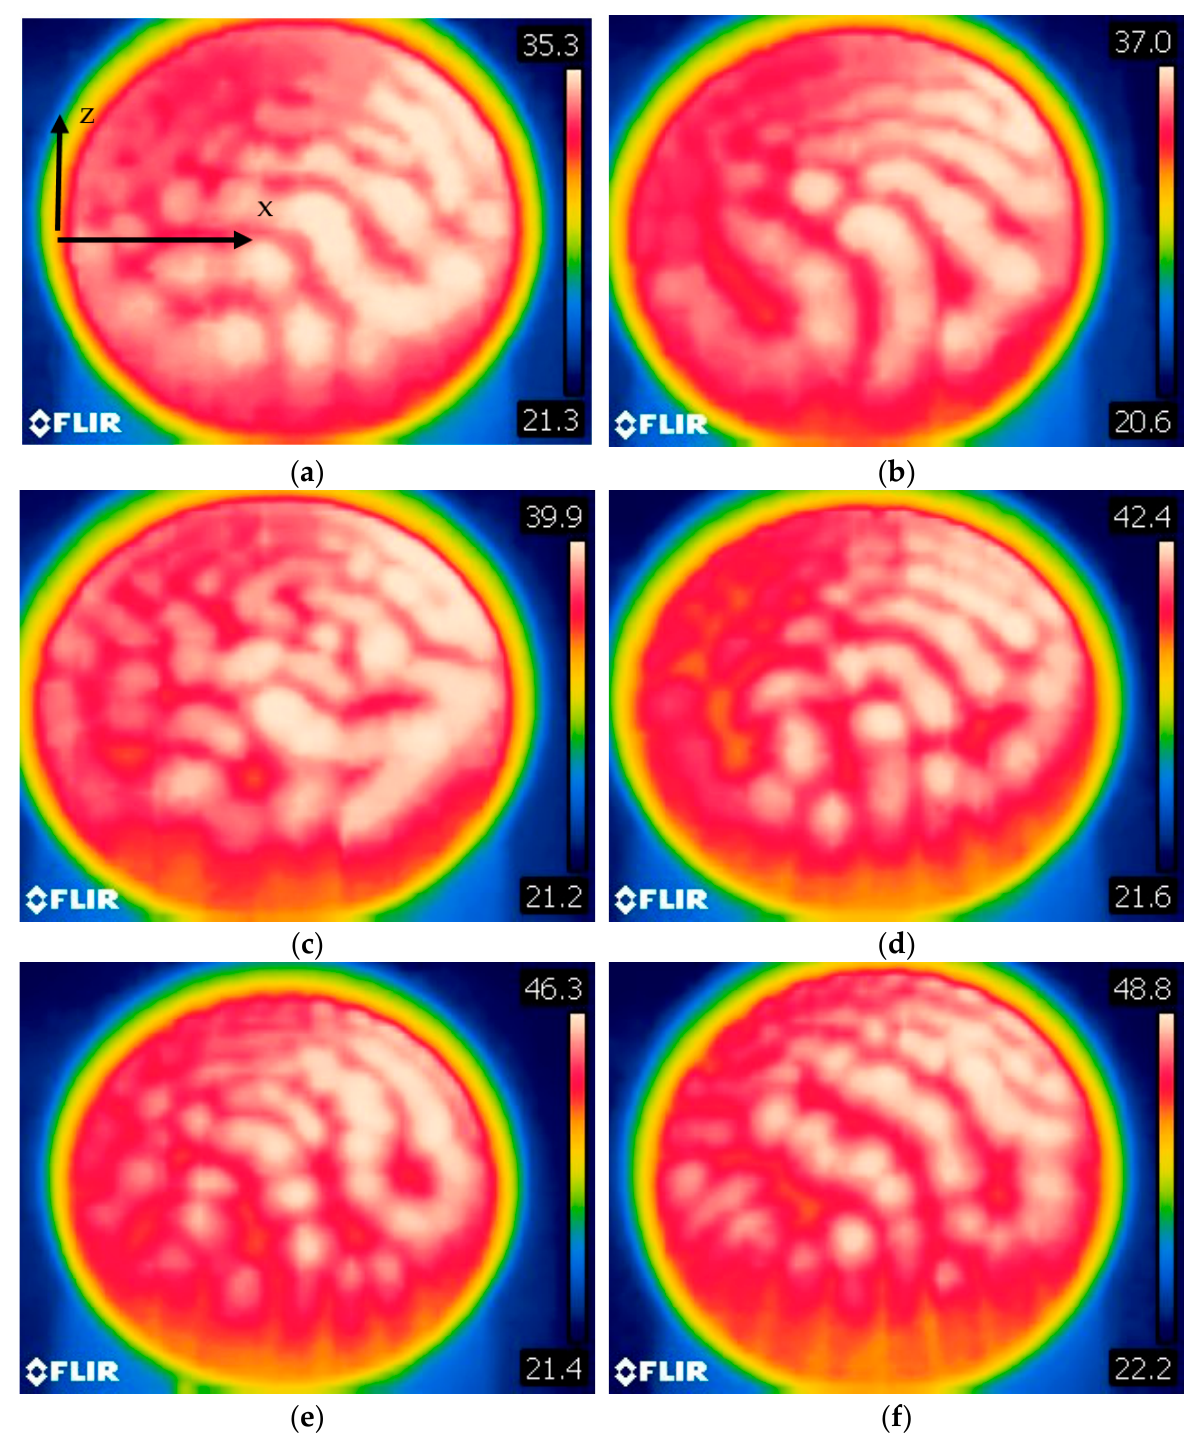
Figure 17. Surface temperature distribution for d = 0.75 cm ( Ω = 104 mL) and ϑ ≅ 3.5° ( A = 17.7, Bo dyn ≅ 1.94, Ra ≅ 8.6 × 10 2 × ∆ T , Ma ≅ 4.4 × 10 2 × ∆ T ) ( a ) ∆ T = 15 °C, ( b ) ∆ T = 18 °C, ( c ) ∆ T = 21 °C, ( d ) ∆ T = 24 °C, ( e ) ∆ T = 27 °C, ( f ) ∆ T = 30 °C (the x and z axes correspond to the horizontal and vertical directions in all the panels).